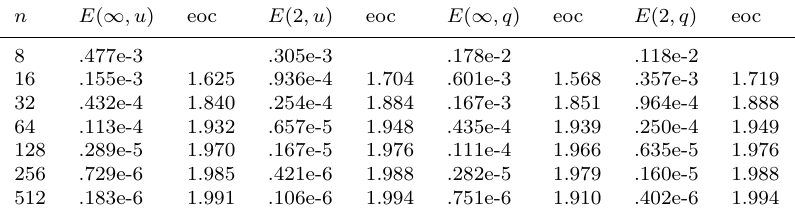
Table 1. Errors and orders of convergence of the P 0 − collocation on the circular arc n